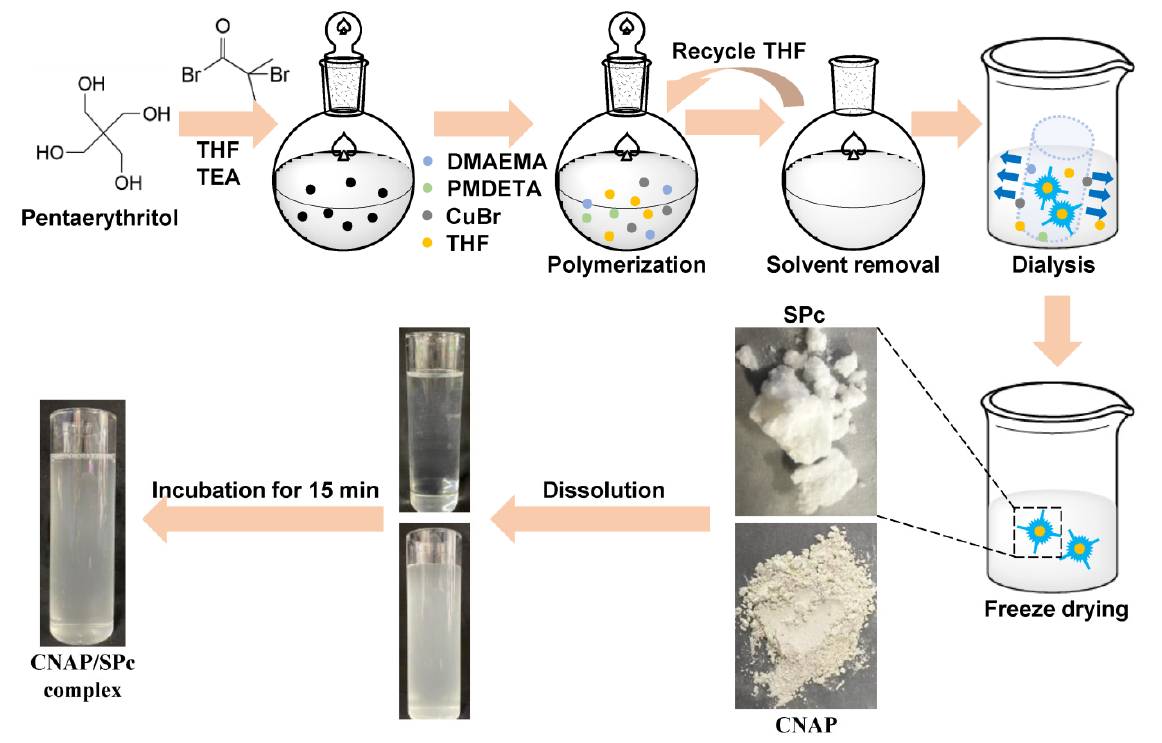
Figure 1. Synthesis route of SPc and preparation of CNAP/SPc complex. Table 1. Loading capacity of SPc toward CNAP using freeze-drying method.